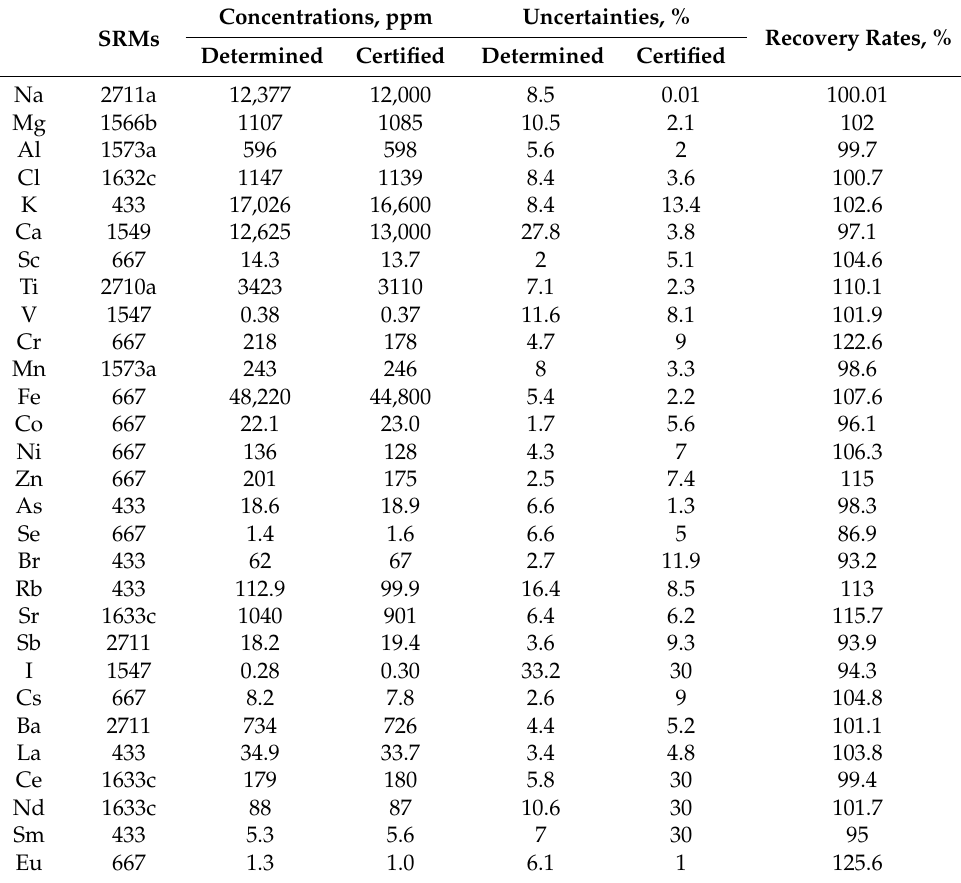
Table 1. Quality control of the neutron activation analysis. Concentrations, SRMs